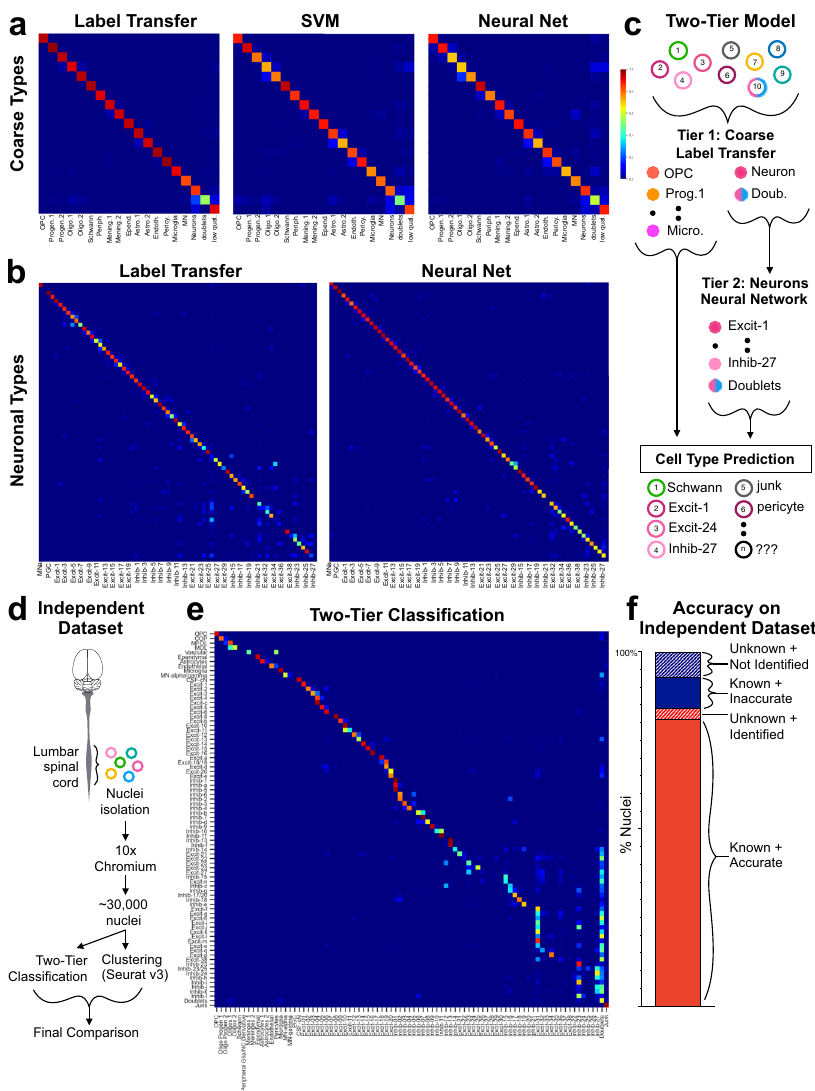
Fig. 6 Computational classi fi cation of spinal cord cell types. a Confusion matrices of the F1 scores for the classi fi cation of coarse cell types using label transfer, a support vector machine (SVM), and a fully connected neural network (neural net), (blue = 0; maroon = 1). The actual cell types are in rows and the predicted cell types are in columns in the same order. b Confusion matrices of the F1 scores for the classi fi cation of fi ne neuronal sub-types using label transfer and a fully connected neural network. The actual cell types are in rows and the predicted cell types are in columns, both in the order presented in Table 1. Alternating cell types are labeled. c Model of the two-tiered classi fi cation approach in which all cells/nuclei are classi fi ed into coarse cell types using label transfer (also including low-quality junk and doublets). Subsequently, all cells/nuclei that were classi fi ed as neurons, motoneurons, or doublets by label transfer are further classi fi ed into 69 neuronal cell types (also including doublets). d Experimental design for generating an independent set of single nucleus RNA sequencing data. e Distribution plot showing how nuclei from each cluster (rows) were distributed into each of the harmonized cell types (columns), normalized by rows with dark blue = 0.0 fraction; maroon = 1.0 fraction). f Bar plot of the total counts of nuclei that were from known clusters and were correctly classi fi ed (81% of total), that were from known clusters and were incorrectly classi fi ed (9% of total), that were from unknown clusters but could be identi fi ed by their classi fi cation (3% of total), or that were from unknown clusters and could not be identi fi ed (7% of total). OPC oligodendrocyte precursor cell, progen.1 oligodendrocyte progenitor 1, progen.2 oligodendrocyte progenitor 2, Olig.1 oligodendrocyte 1, Olig.2 oligodendrocyte 2, Periph. peripheral glia, Mening.1 meninges 1, Mening.2 meninges 2, Epend. Ependymal cells, Astro.1 astrocytes 1, Astro.2 astrocytes 2, Endoth endothelial cells, Pericy pericytes, MN = motoneurons; low qual. low quality, MNa motoneurons alpha, PGC preganglionic